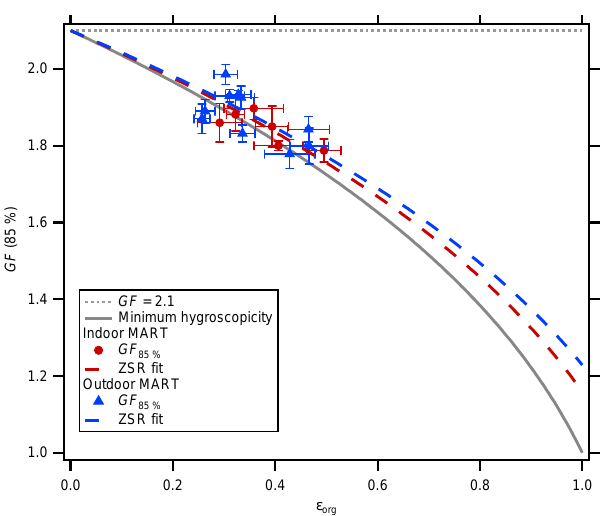
Figure 4. PM all GF(85%) as a function of the organic volume fraction estimated from AMS non-refractory organic matter (NR- POM)/PM 1 mass for the indoor (red circles) and the outdoor (blue triangles) MARTs. ZSR fits to the data using Eq. (5) are shown for the indoor (dashed red line) and outdoor (dashed blue line) MARTs, assuming GF sea salt (85%) = 2.1 (dotted gray line). The overall re- trieved GF org (85%) values were 1.16 ± 0.09 and 1.23 ± 0.10 for the indoor and outdoor MARTs, respectively. The gray solid line connecting GF(85%) = 2.1 and GF org (85%) = 1.0 provides the minimum value expected for any combination of